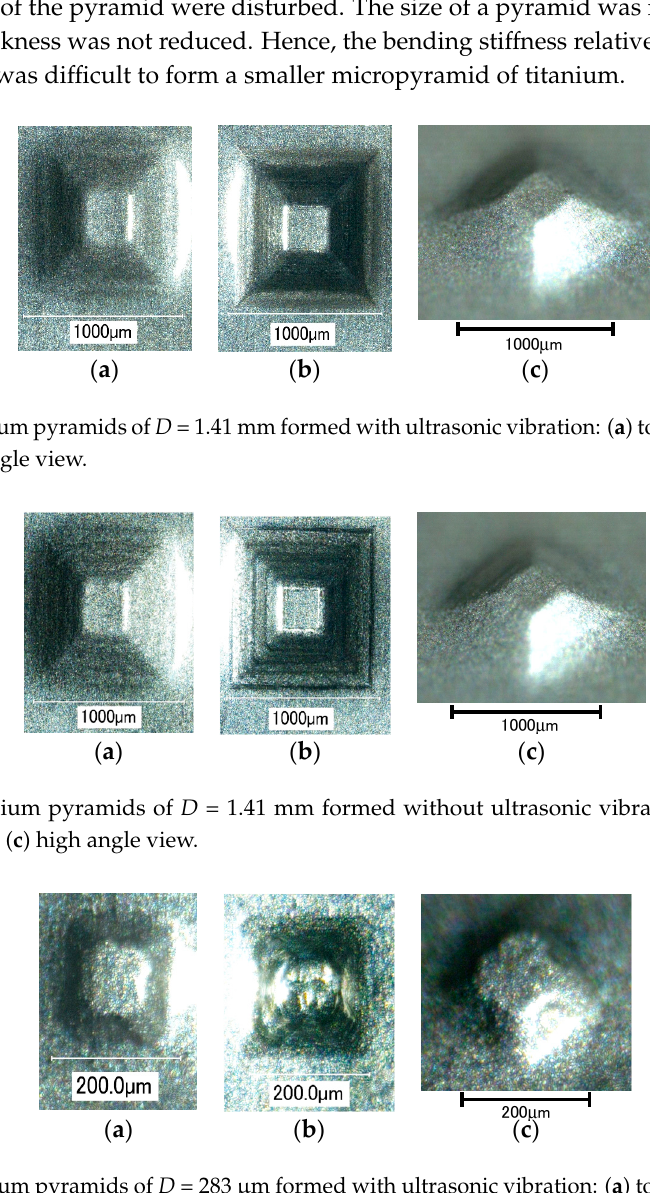
Figure 16. Titanium pyramids of D = 283 μ m formed with ultrasonic vibration: ( a ) top view; ( b ) bottom view; ( c ) high angle view.